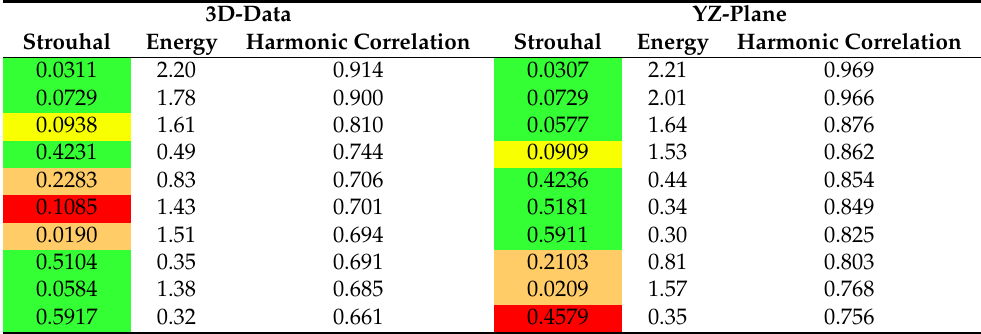
Table 1. The data from the SPOD-analysis of the 3D data set and the YZ-data, colored by their deviation in terms of the Strouhal number between the 2D- and 3D-data. 3D-Data YZ-Plane Strouhal Energy Harmonic Correlation Strouhal